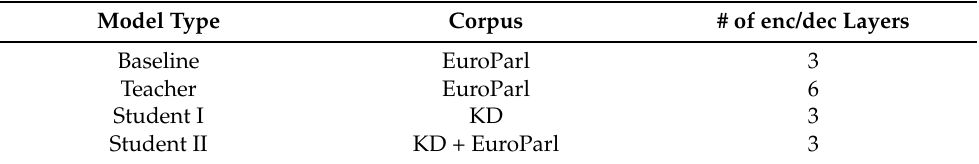
Table 2. Comparison of baseline, teacher and student models. (KD is the knowledge-distilled training set).